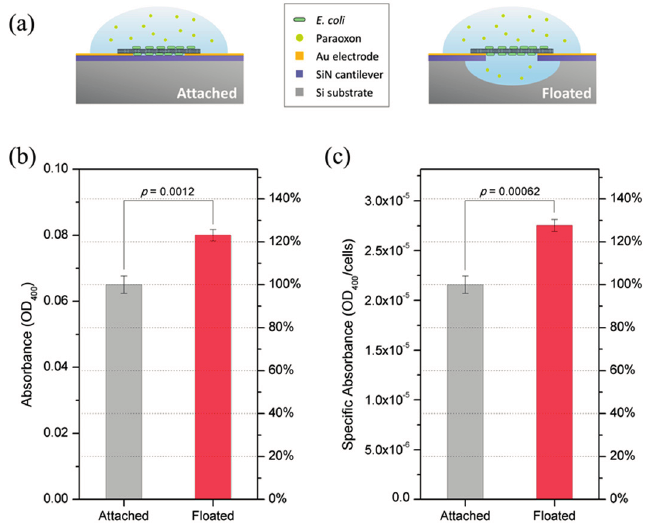
Figure 4. Device Activity. ( a ) Schematic representation of attached and floating E. coli- attached SWNT films. The floating film device has space for floating the E. coli- attached SWNT film from the surface of the device. On the other hand, the device for attached film did not undergo the etching process of silicon and silicon nitride to produce the film on the surface of the device; ( b , c ) show the comparison of enzymatic activity between the attached and floating films (b) per device and (c) per cell. Error bars indicate standard